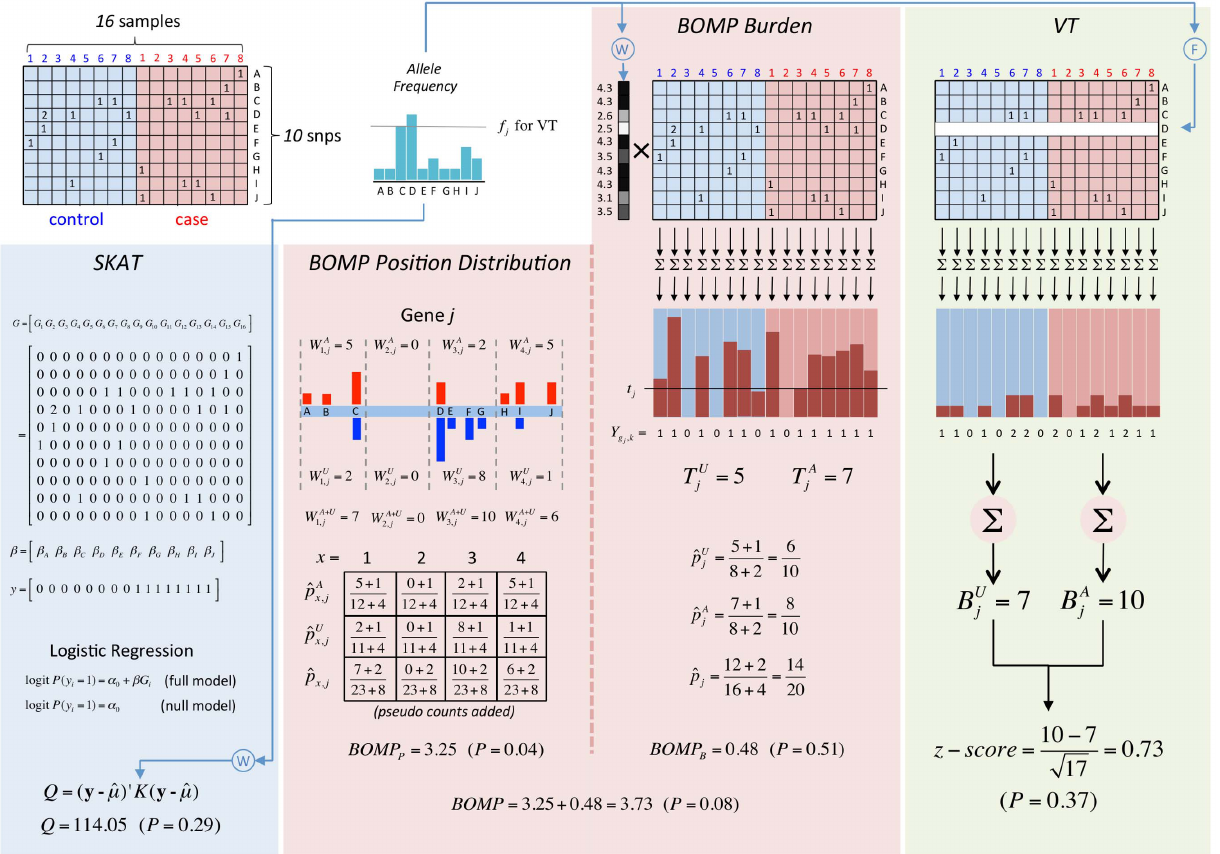
Figure 7. Analytical comparison of SKAT, BOMP, and VT on a toy example. Genotypes of 8 cases and 8 controls at 10 positions. Matrix column colors: controls=light blue, cases=light red. Position distribution bar colors: controls=blue, cases=red. Detailed description is in the section ‘‘Toy example with analytical calculations’’ (Text S1).